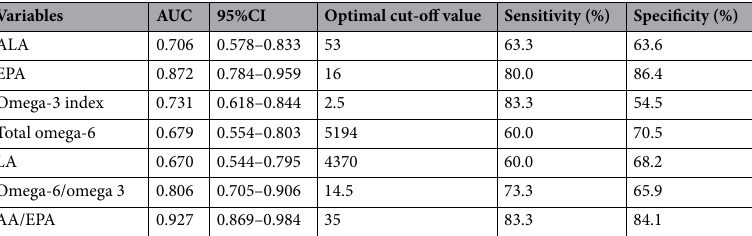
Table 3. Predictive value of seven LCPUFA parameters in showing the risk of severe